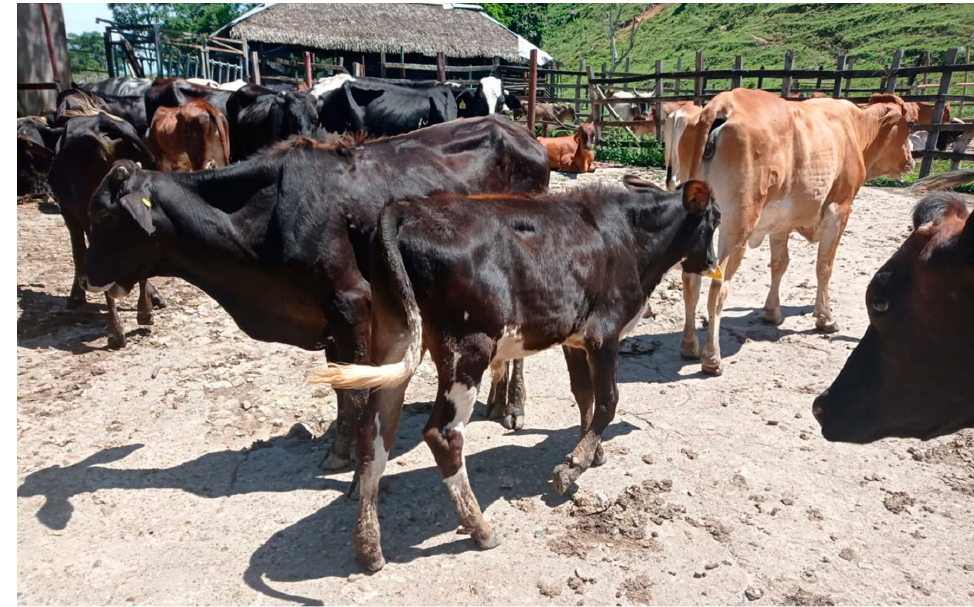
Figure 4. Clinical signs in a cattle herd (photo courtesy of Dr. JJ Bustamante).